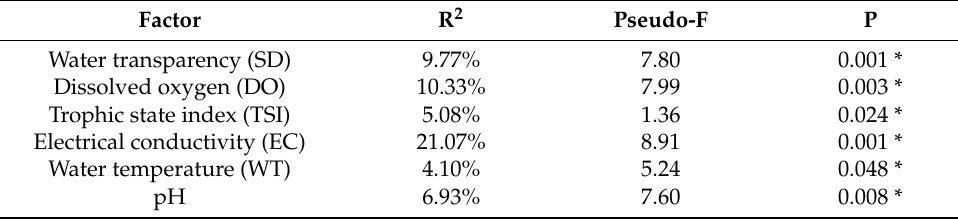
Table 4. Permutation test results for RDA models, constructed for each variable. Factor R